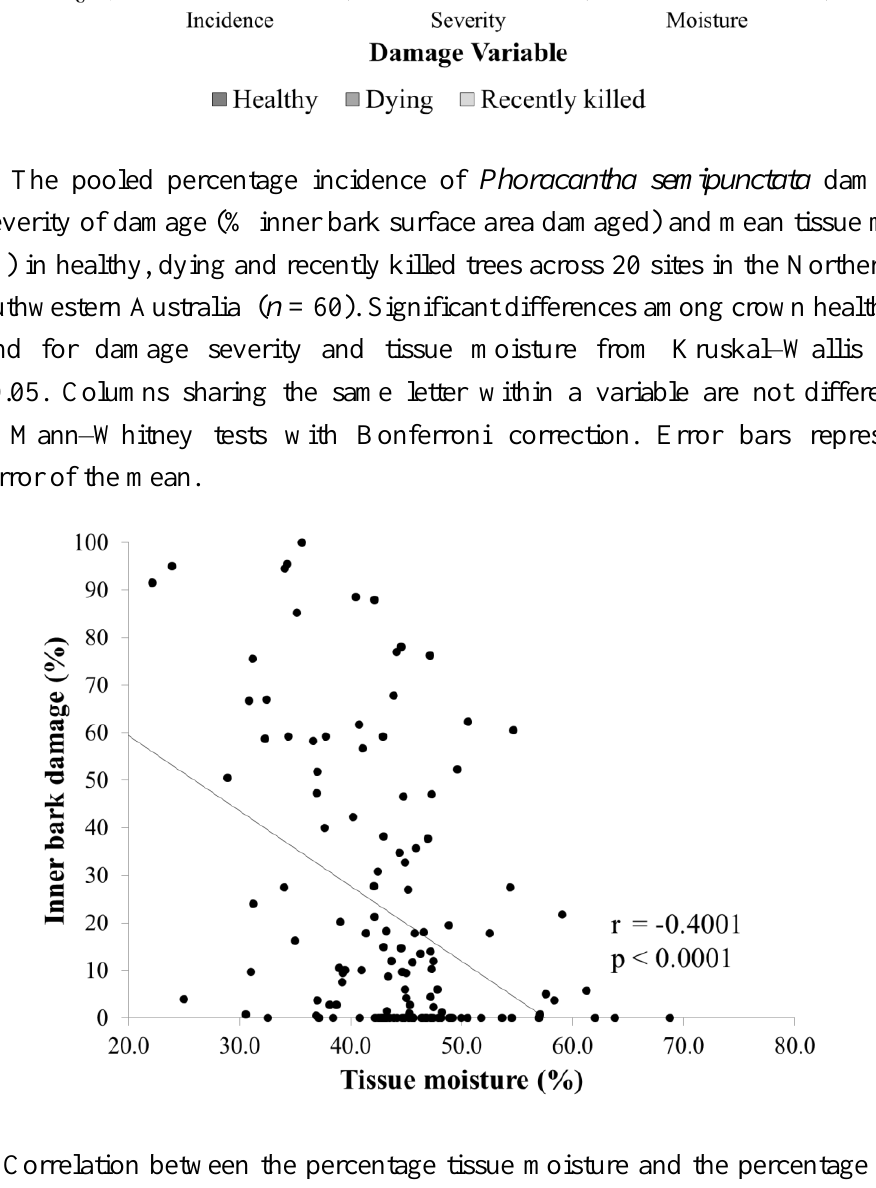
Figure 3. Correlation between the percentage tissue moisture and the percentage of inner bark damaged from Phoracantha semipunctata in the Northern Jarrah Forest, southwestern Australia. A significant relationship was determined from Spearman Rank correlation at alpha =